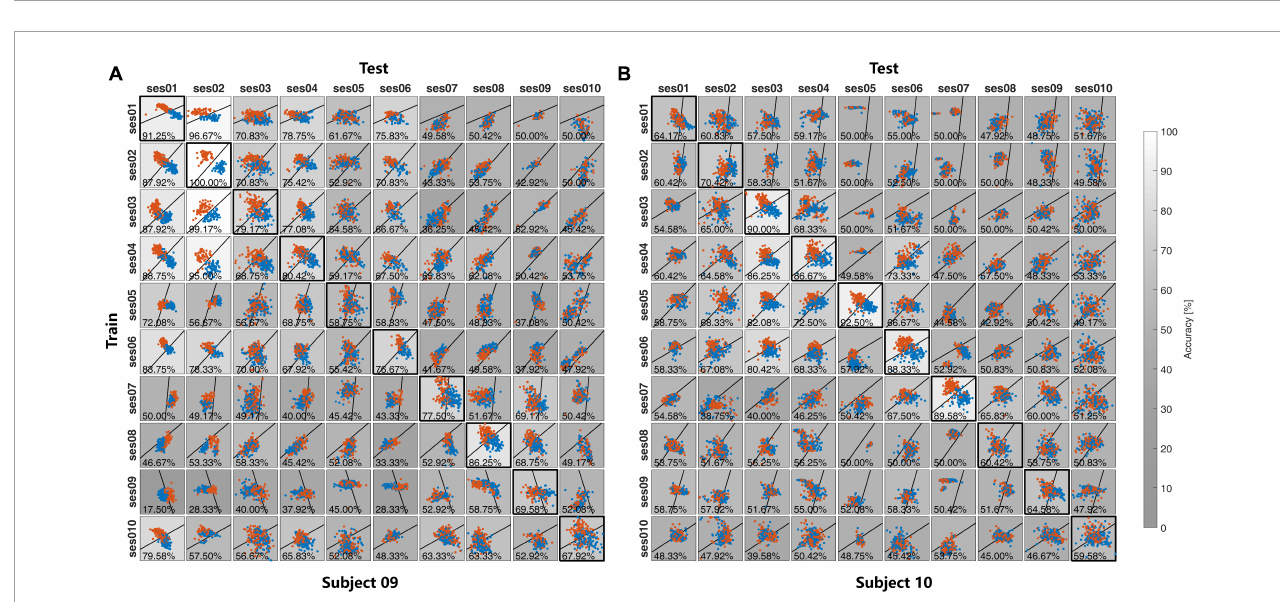
FIGURE7 The feature distribution and the classification accuracies in the cross-session in (A) Subject 09 and (B) Subject 10 in